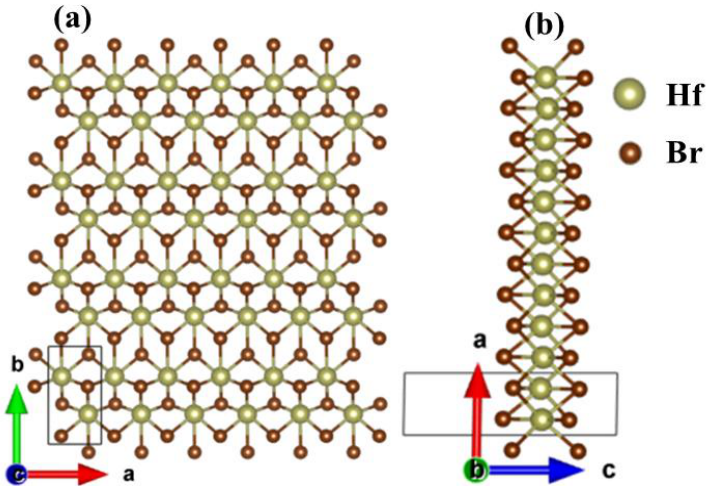
Figure 1. Top ( a ) and side ( b ) views of the 6 × 4 × 1 supercell structure for the monolayer Hf 2 Br 4 . The unit cell is delimited by solid line. The unit cell is delimited by solid